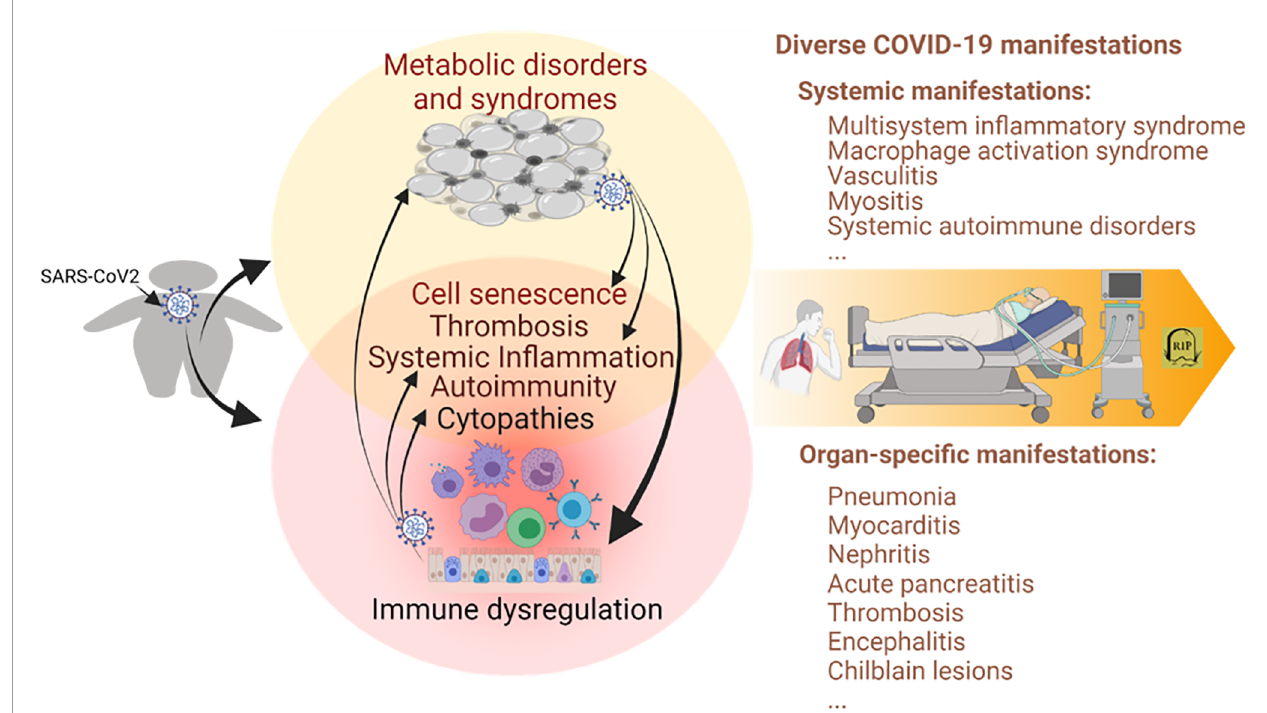
FIGURE 1 | Immunometabolic proxies underlying the association between obesity and the severe course of COVID-19. Studies have associated the propensity of severe COVID-19 manifestation in patients with obesity and relevant metabolic comorbidities. The emerging theme indicates the immuno-pathological exaggeration of predisposed immuno-metabolic disorder (indicated in the circles, especially the overlapped region on the left) in the obese COVID-19 patients. This predisposed immunometabolic disorder magni fi es, locally and systemically, the virus pathogenicity and relevant immunopathies leading to more severe COVID-19 manifestations. COVID-19, coronavirus disease 2019; SARS-CoV-2, severe acute respiratory syndrome coronavirus 2. Created with